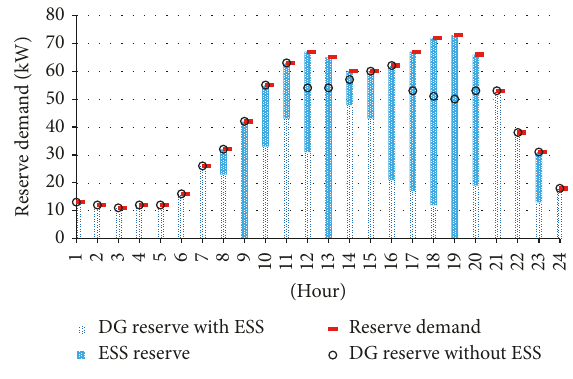
Figure 7: Reserve condition in Case